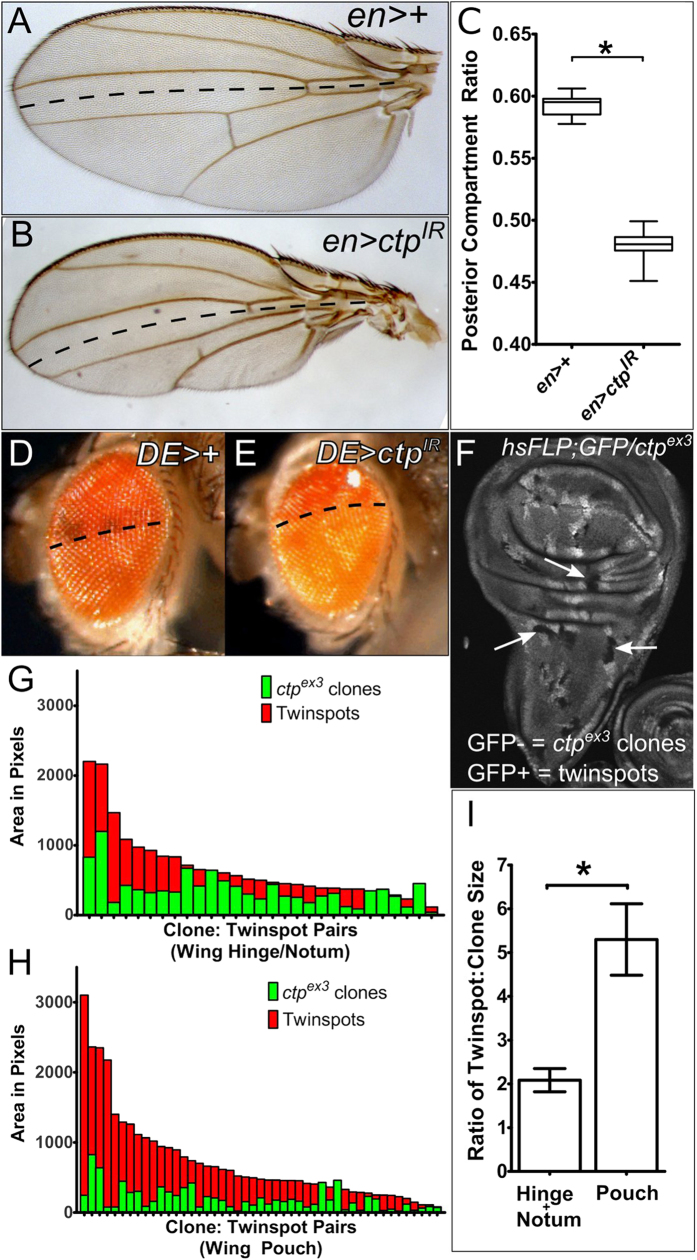
ctp loss reduces compartment size and clonal growth.Paired images of control (A,D) and Ctp-depleted (B,E) adult wings and eyes generated using the en-Gal4 (A,B) or mirrDE-Gal4 (AKA dorsal eye (DE)-Gal4) (D,E) drivers in combination with the ctpIR transgene. en is expressed in posterior wing cells (below dotted line in (A,B)). DE is expressed in dorsal eye cells (above dotted line in (D,E)). (C) Box-plot quantitation of the wing posterior compartment ratio (PCR = P area/P + A areas) of the genotypes in (A) (n = 22) and (B) (n = 31). Standard error of the mean (SEM) is indicated. *p < 0.0001. (F) Confocal image of a ctp mosaic L3 wing disc (ctpex3,FRT19A/ubi-GFP,FRT19A,hsFlp) containing GFP-negative ctpex3 clones (arrows) and their paired GFP-positive twinspots. (G,H) Histogram plots of the two-dimensional area of multiple ctpex3 clone:twinspot pairs in the hinge/notum (G) (n = 29) or pouch (H) (n = 47) of L3 wing discs. Each pair of bars on the X-axis represents a distinct clone:twinspot pair. The clones are significantly smaller than their paired twinspots, *p = 0.0002 for (G), *p < 0.0001 for (H). (I) Bar graph plot of average ratios of ctpex3 clone:twinspot sizes in the hinge/notum versus the pouch. SEMs are indicated. *p = 0.0034.